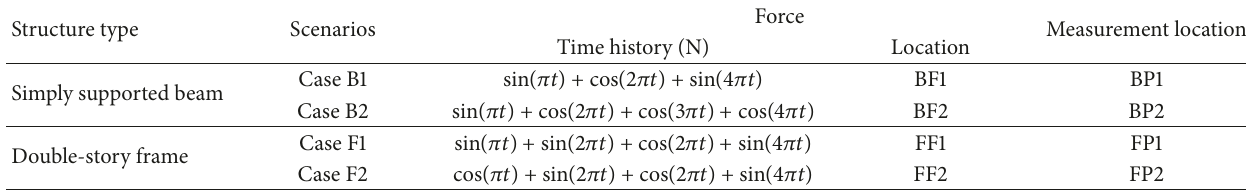
Table 1: Scenarios considered in the numerical simulations.